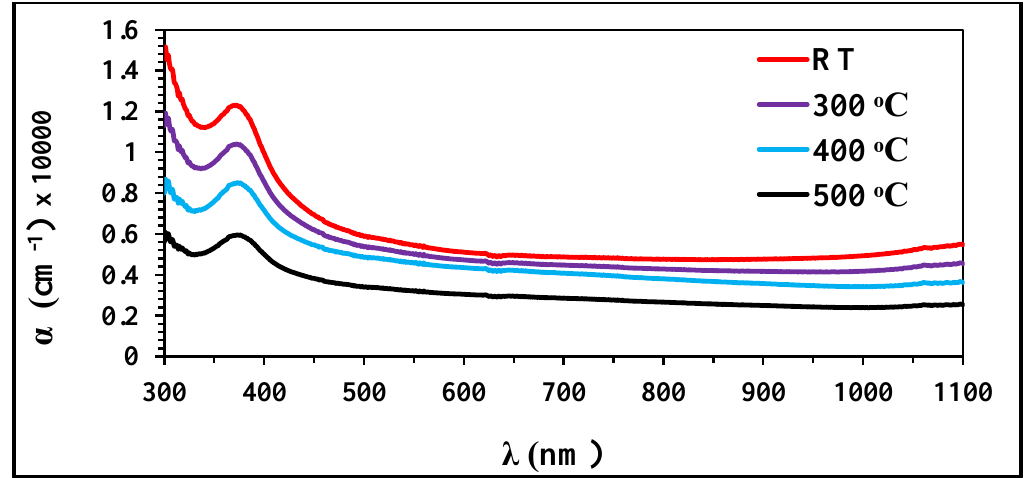
Fig. 6: Absorption coefficient as a function of the wavelength for the Cr annealing